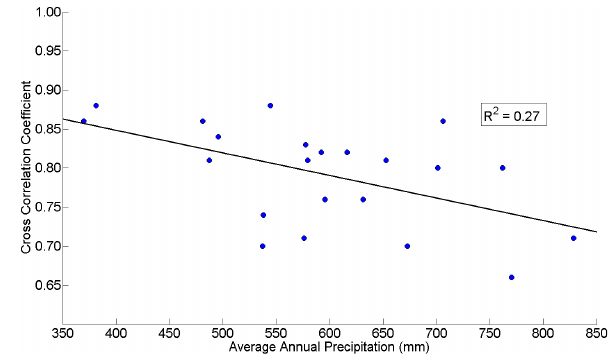
Fig. 6. Peak cross correlation ( r ) between the 5 and 25cm layers Figure 6. Peak cross correlation (r) between the 5 and 25 cm layers for all Oklahoma sites versus for all Oklahoma sites versus the average annual precipitation. Each the average annual precipitation. Each point represents one site. point represents one site.